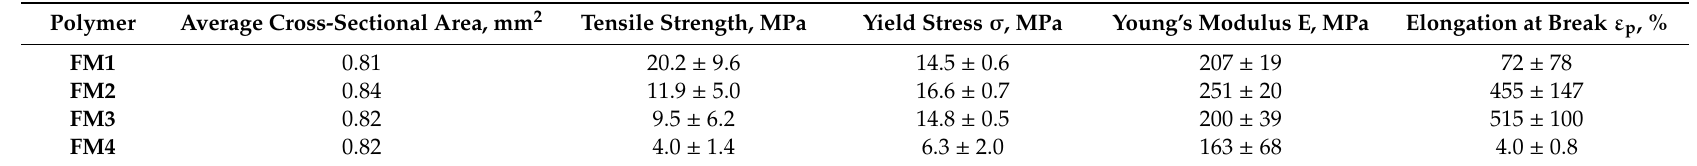
Table 2. Tensile properties of polymer